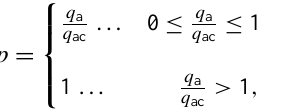
2 Capacity-based Saltation-Abrasion (CSA) geomorphic incision law and its implications for channel evolution: upstream-migrating waves of